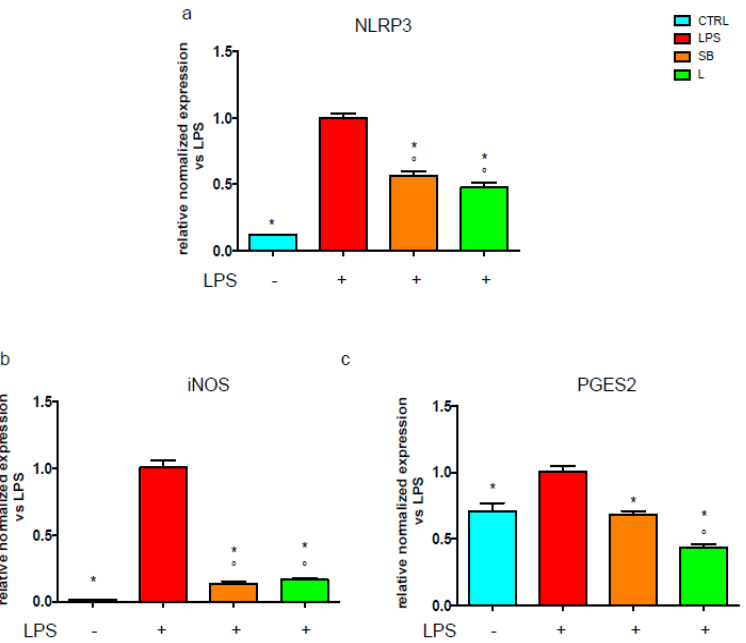
Figure 5. RT-PCR analysis of inflammatory markers gene expression in BV-2 cells treated with chest- nut extracts. BV-2 cells were treated with spiny bur (SB) or leaf (L) extracts (0.5 mg/mL) for 3 h, then stimulated (or not) with 0.5 μ g/mL LPS (red bars) for a total of 24 h. At the end of incubation, RNA was extracted, and samples were subjected to RT-PCR analysis using specific primers for ( a ) NLRP3, ( b ) iNOS, and ( c ) PGES2, as reported in the Materials and Methods section. The relative mRNA contents were normalised to LPS-treated cells. Relative quantification is obtained as described in the Materials and Methods section; results are expressed as means ± SEM of three independent ex- periments. Statistical analysis was performed by Fisher’s LSD test following one-way ANOVA. ° p < 0.05 significantly different from control cells; * p < 0.05 significantly different from LPS-treated cells.